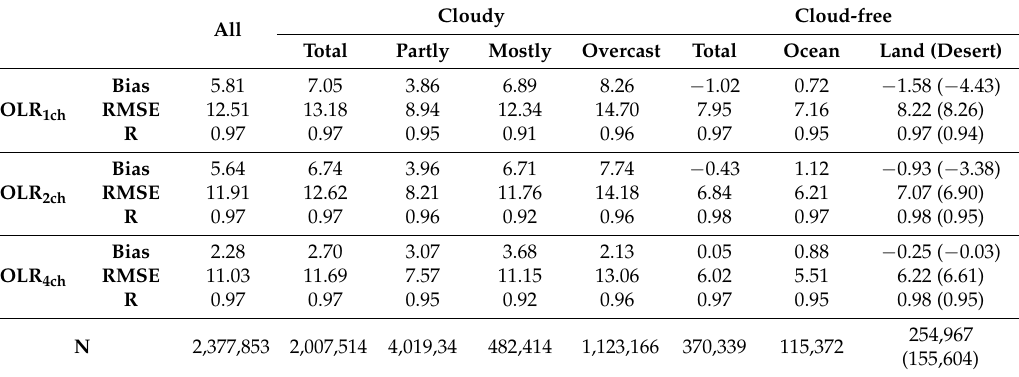
Table 7. Mean of bias, RMSE, and correlation coefficient (R) for the CERES OLR and AHI OLR calculated for all cases in 2017 and the number of analysis cases. The unit for bias and RMSE is Wm − 2